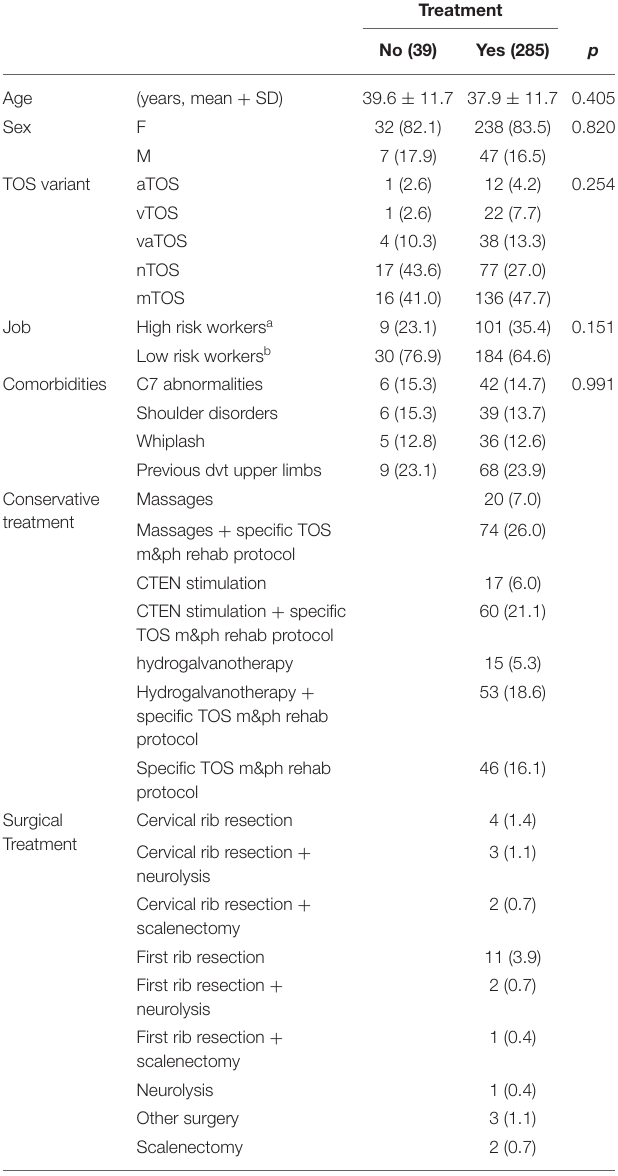
TABLE 2 | Demographics of the investigated population.